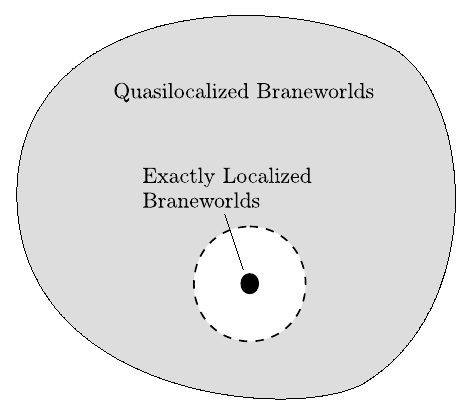
Figure 4 . Cartoon of the space of braneworld EFTs with gravity. The gray region represents the parameter space of quasilocalized braneworld